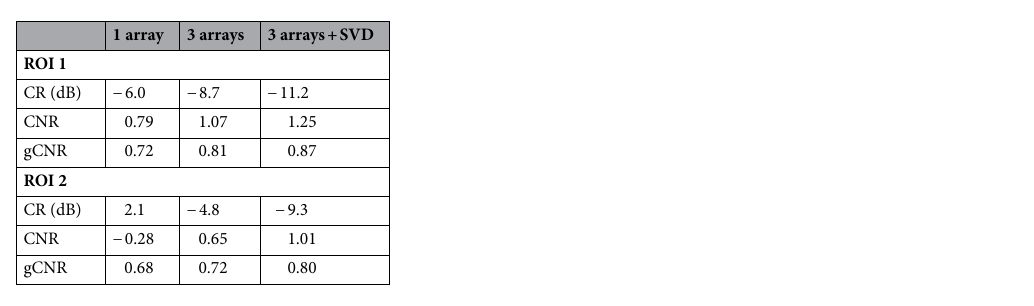
Table 3. Evaluation of contrast ratio (CR), contrast-to-noise ratio (CNR) and generalized contrast-to-noise ratio (gCNR) in the liver from the acquisition shown in Fig.